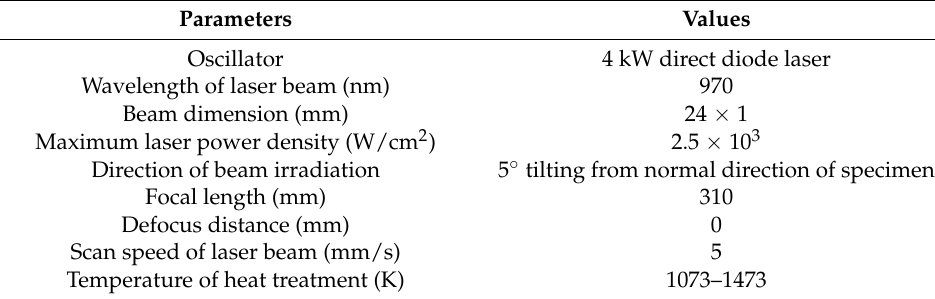
Table 2. Conditions for laser-assisted heat treatment.